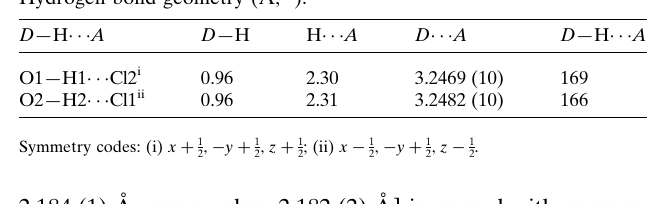
Table 1 Hydrogen-bond geometry (A˚ , (cid:3) ).